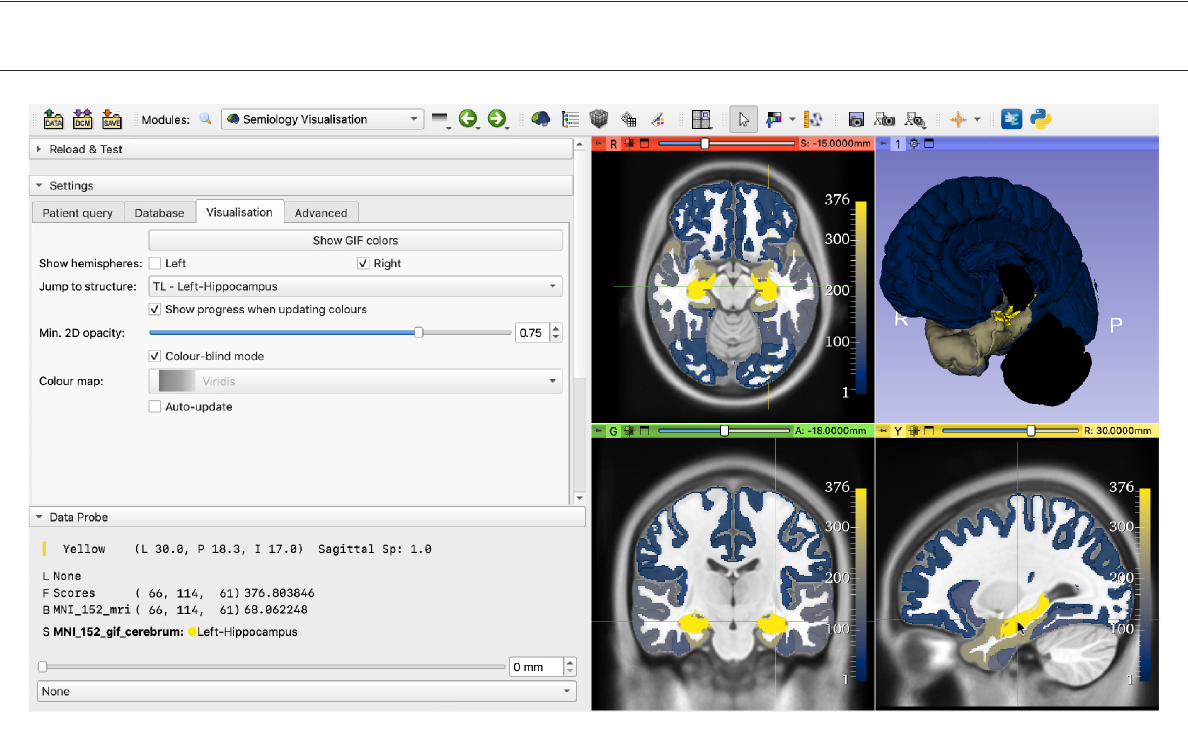
FIGURE6 Demonstration of advanced visualization settings. The selected settings are: show only the right hemisphere, center the views on the right thalamus, set minimum opacity to 75% (default is 25%) and enable color-blind